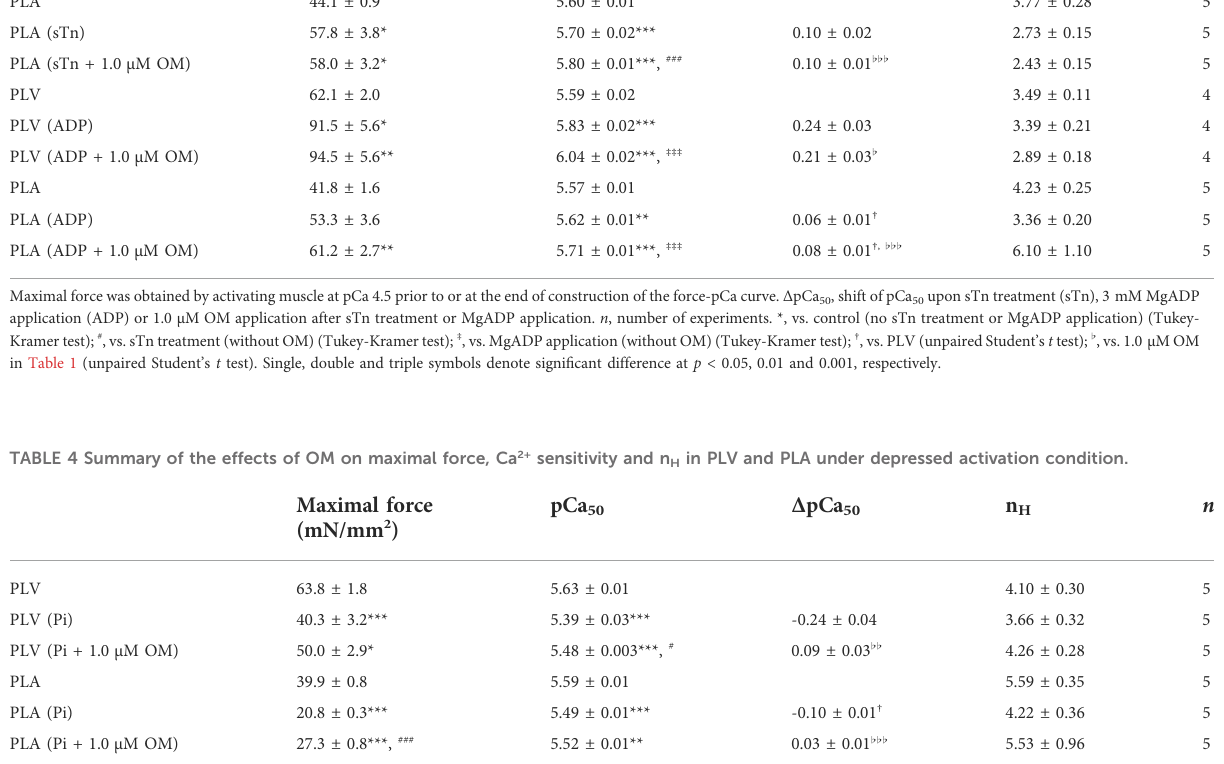
right shifting pCa 50 by 0.10 ± 0.01 pCa units (Figure 5B; Table 4).